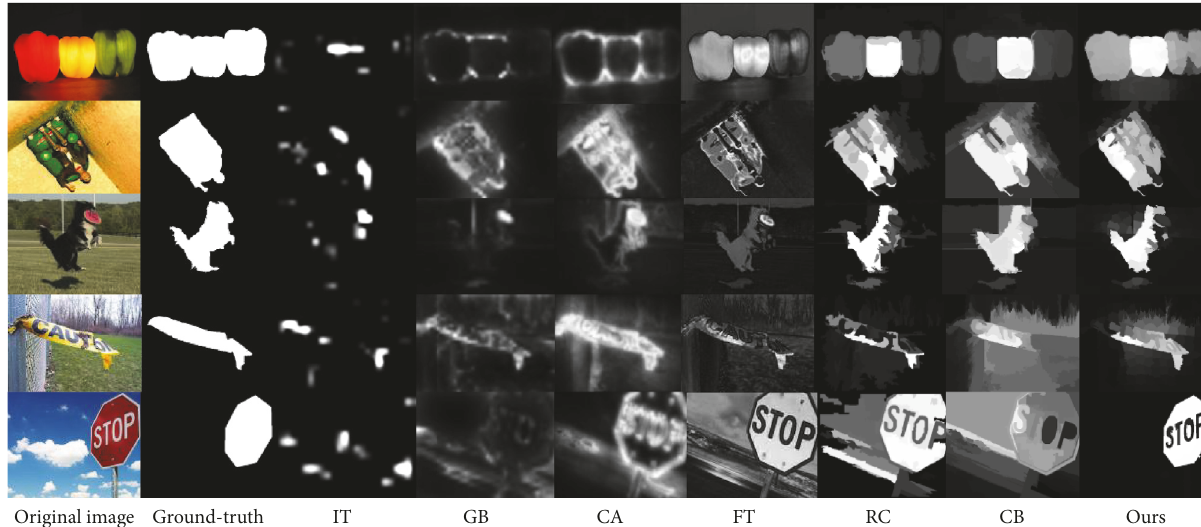
Figure 6: Comparison of different saliency detection algorithms.